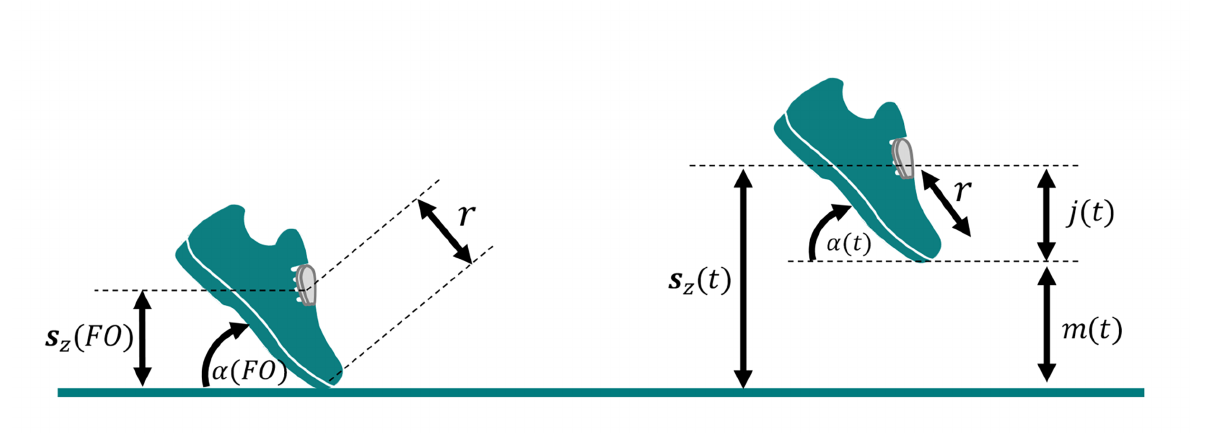
Figure 4. Variables involved in the calculation of toe